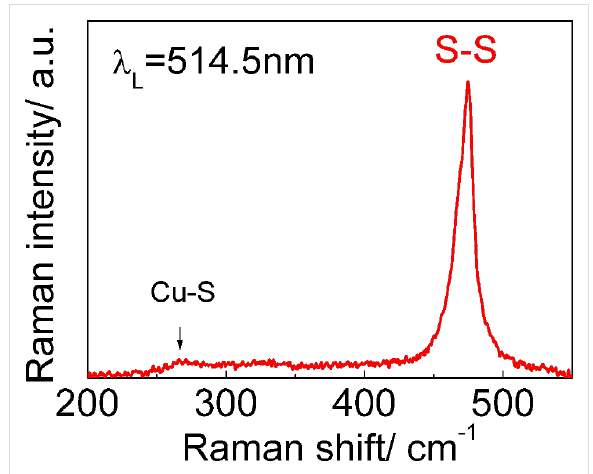
Figure 1: A typical Raman spectrum of the dense ensemble of CuS NCs (about 5–6 MLs) on a Au substrate excited with 514.5